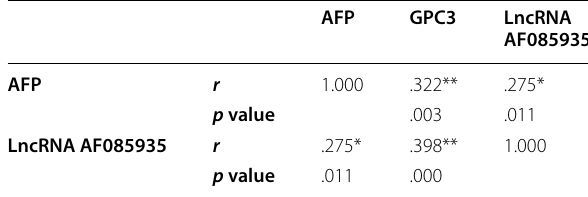
Table 5 Correlation analysis between the studied parameters in the HCC group